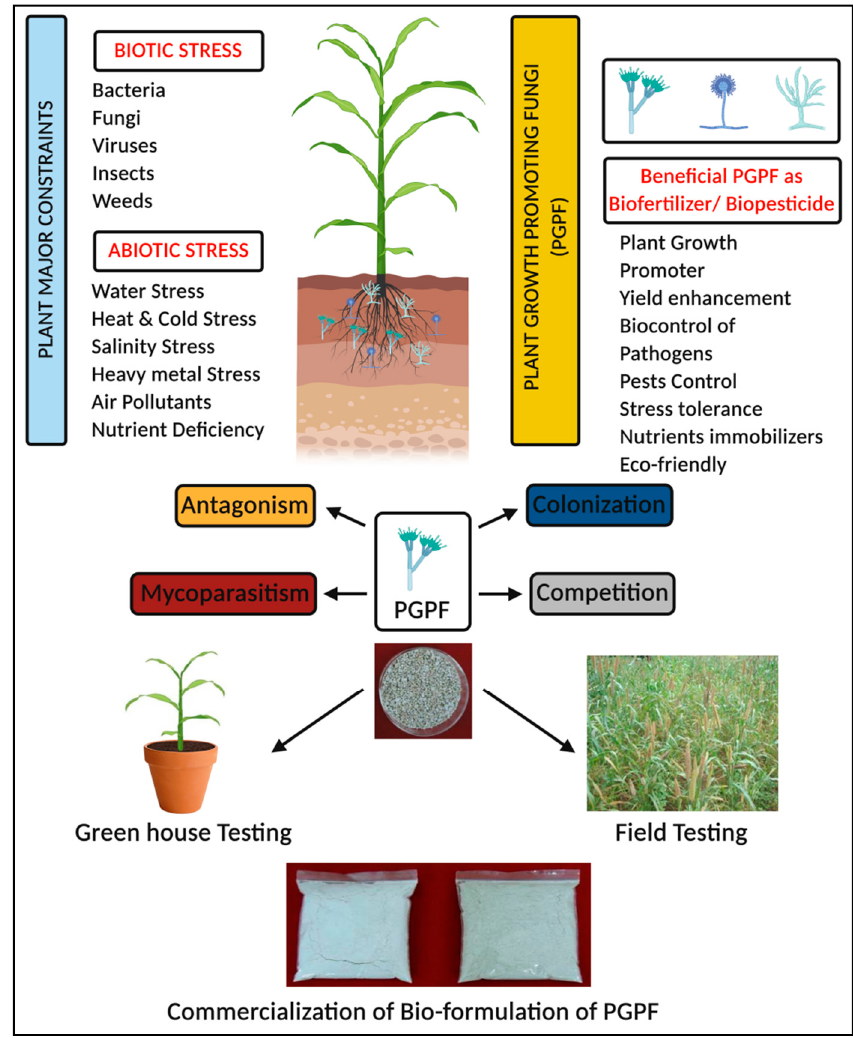
Figure 3. Application of PGPF and its effect on the induced resistance in plants.